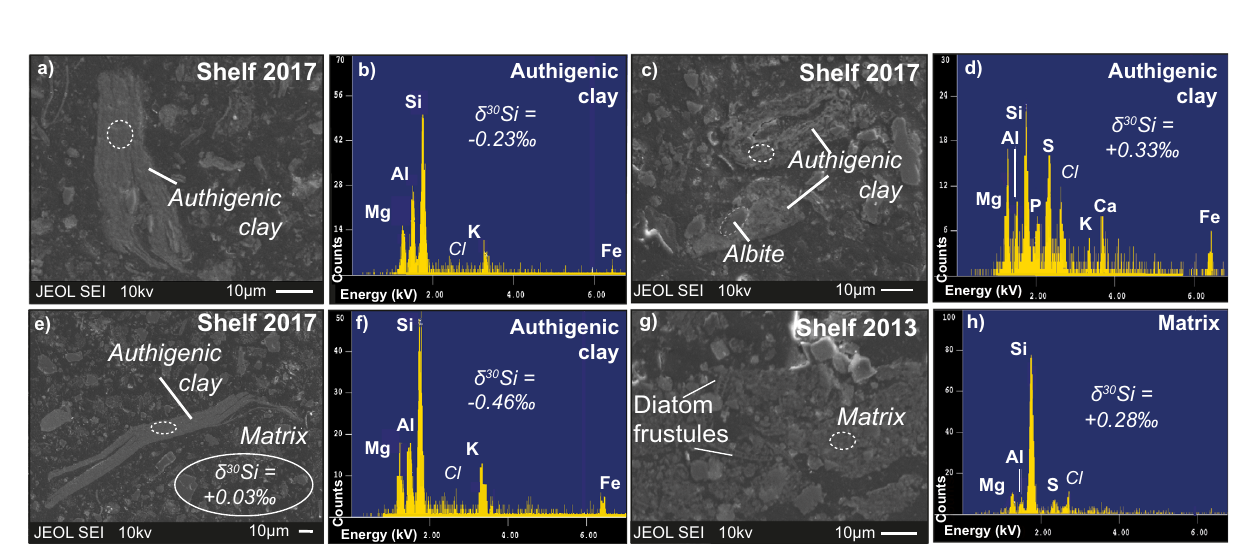
Fig. 3 | Characteristics of authigenic clays. Electron microprobe images and semiquantitative mineral analyses of Peruvian shelf samples from 2013 and 2017 (both from 0.5cmbsf). a – f Filmy, veil-like authigenic clays in Peruvian shelf sedi- ments from 2017 are enriched in Si, Al, Mg, K, and with minor amounts of Fe (measurement spots indicated by dashed white ovals). Note the potential authi- genicclayandbio fi lmassociationin d indicatedbythepresenceofPandS,similar